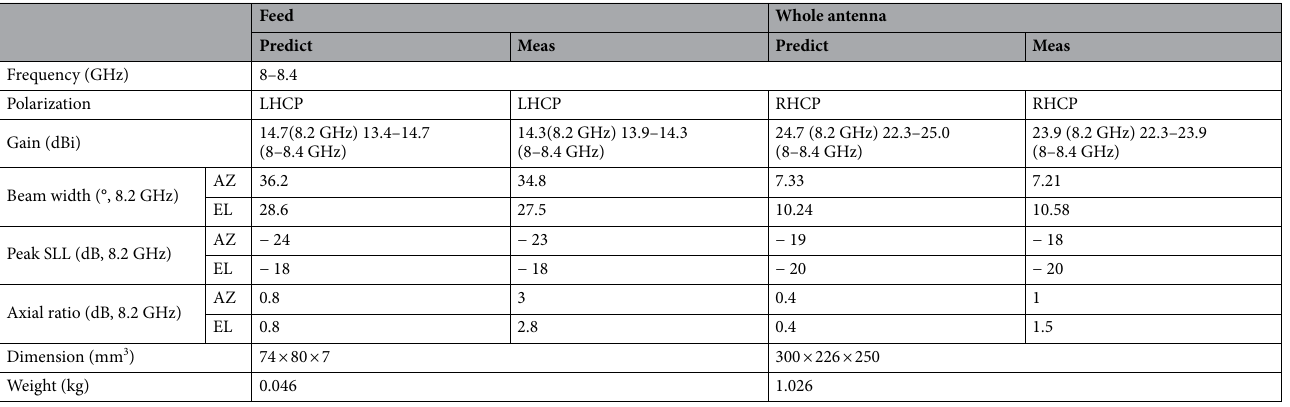
Table 1. Antenna performance